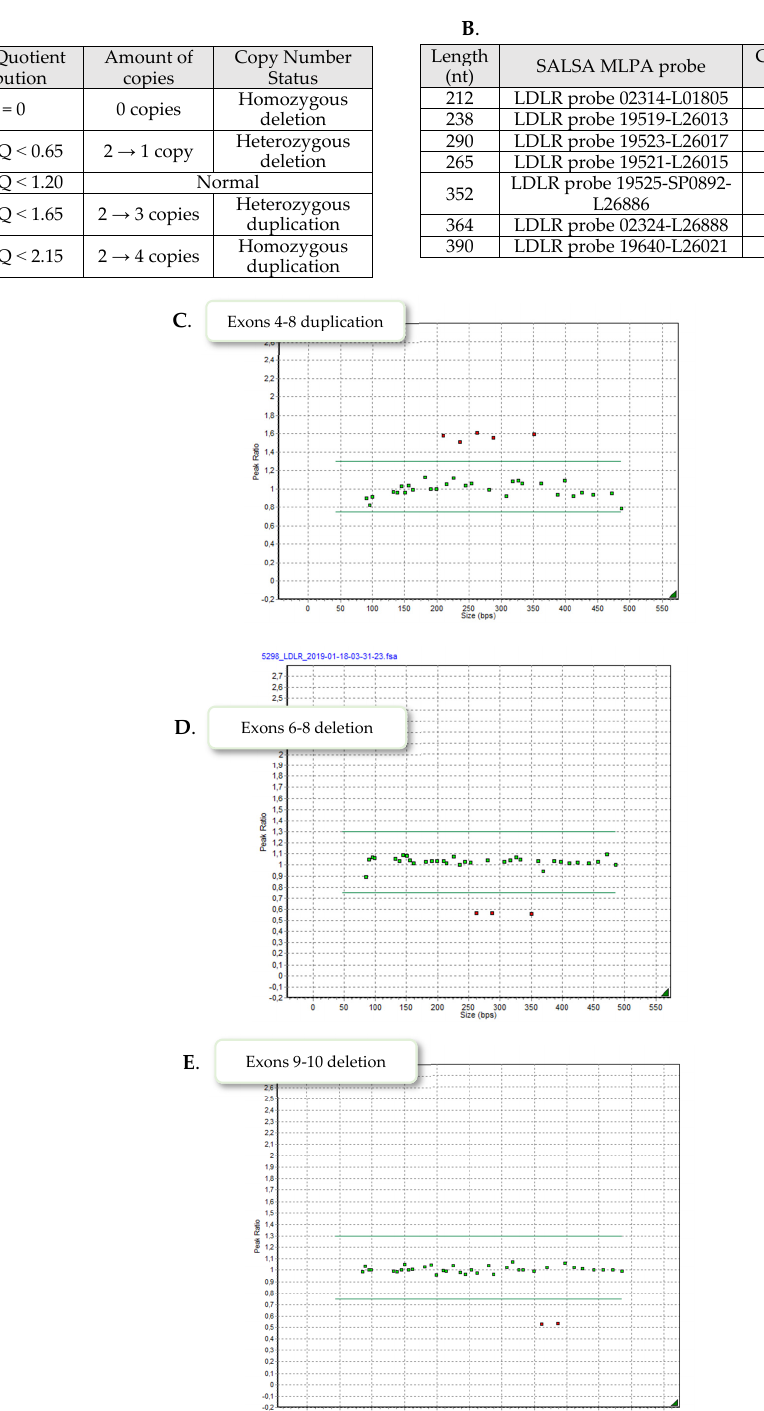
Figure 2. ( A ). Cut-off values for dosage quotient distribution, the equivalent number of copies and homo/heterozygosity state. ( B ). MLPA (multiplex ligation-dependent amplification) fragment length, SALSA MLPA probe numbers and their chromosomal position. ( C ). MLPA plots presenting exons 4–8 duplication of LDLR . The peak ratios of five probes oscillate in the range of 1.5–1.6 which corresponds to heterozygous duplication. ( D ). MLPA plots presenting exons 6–8 deletion of LDLR . The peak ratios of three probes oscillate in the range of 0.5–0.6 which corresponds to heterozygous deletion. ( E ). MLPA plots presenting exons 9–10 deletion of LDLR . The peak ratios of two probes oscillate in the range of 0.5–0.6 which corresponds to heterozygous